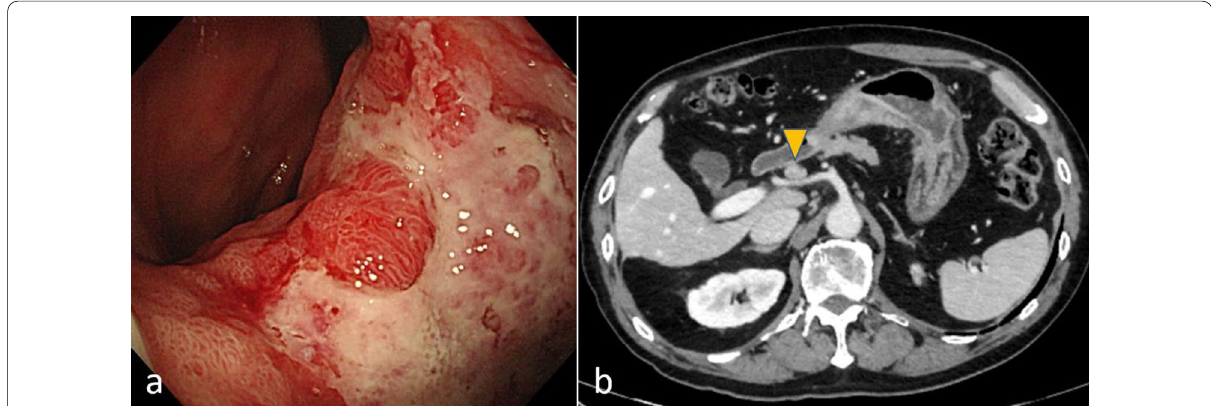
Fig. 1 Findings of case 1 with gastrointestinal endoscopy and abdominal computed tomography before treatment. a A type 3 gastric cancer in the lesser curvature extending to the posterior wall of the middle to lower gastric body was found. b The station No. 8a lymph node (arrowhead) was